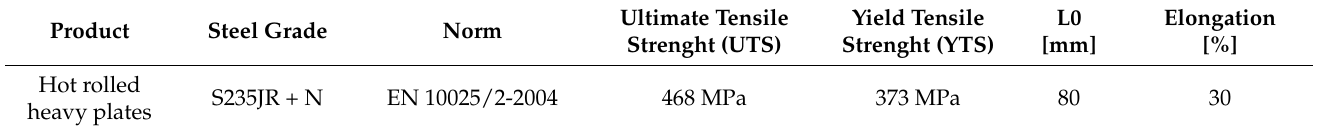
Table 4. Chemical composition of S235JR + N mild steel plates used in this study according to norm EN 10025/2-2004.